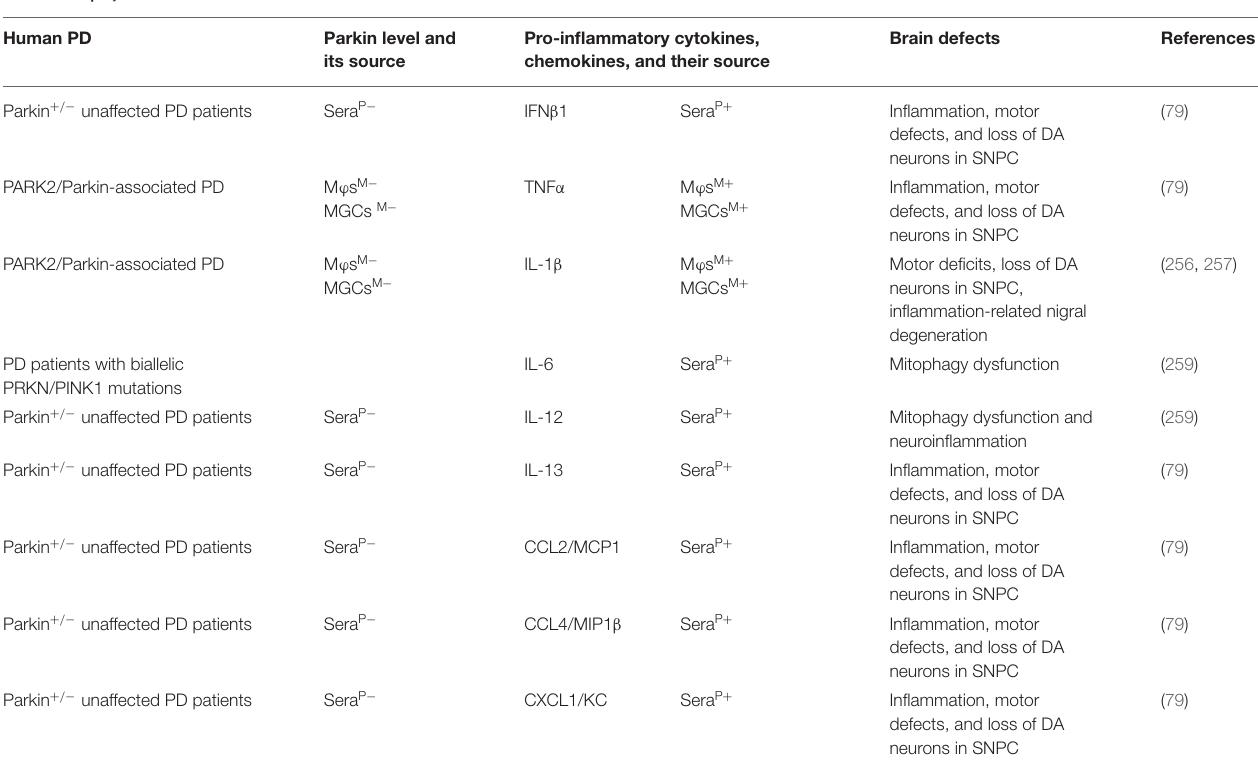
TABLE 5B | Cytokines and their source in the PARK2-associated human PD. Human